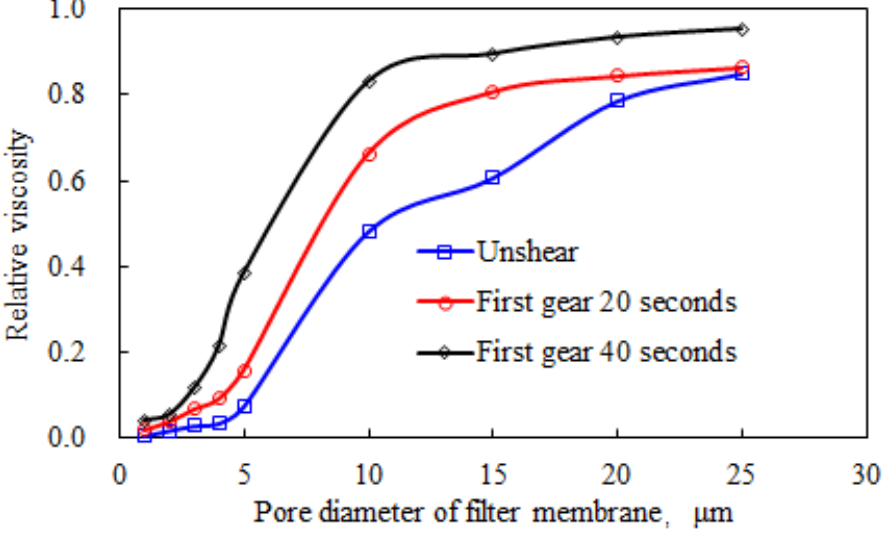
Figure 6. Effect of Shear on AP-P4 Hydrodynamic